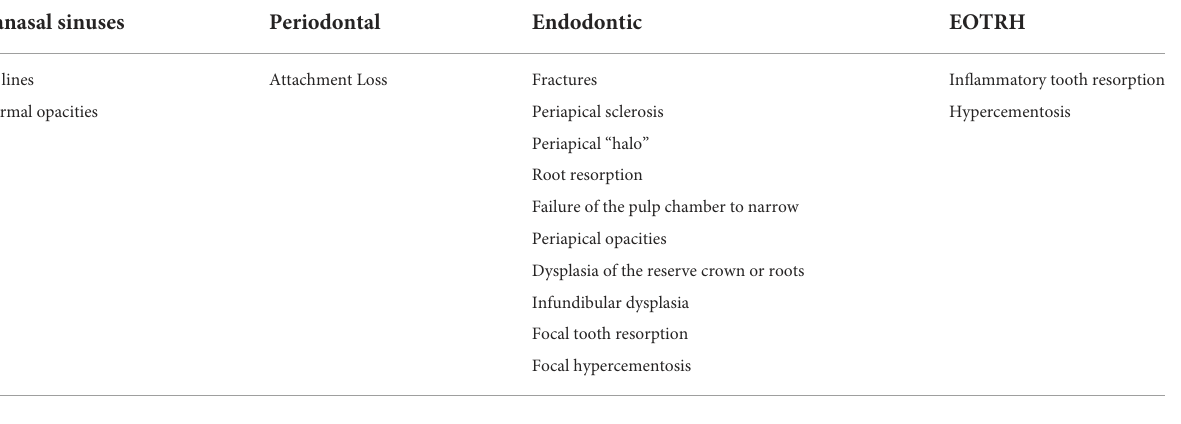
TABLE 2 Tabulated radiographic findings.